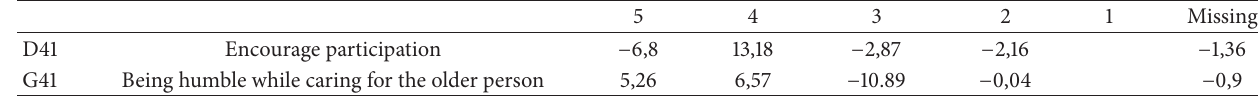
Table 13: Effects on distribution function when A41 fixed to “4” = 100%.